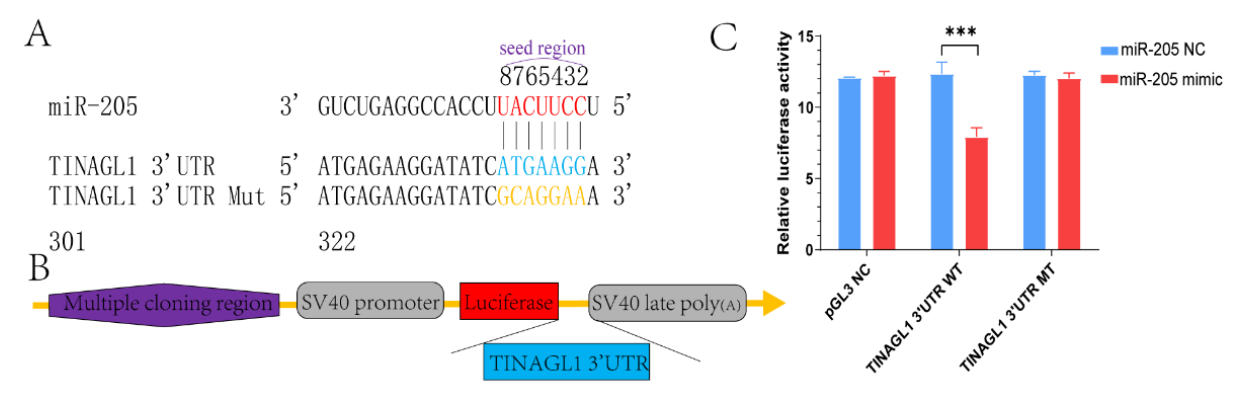
Figure 9. miR-205 targets the 3 (cid:48) -untranslated regions (3 (cid:48) UTR) of tubulointerstitial nephritis antigen-like 1 ( TINAGL1 ). ( A ) miR-205 seed sequence and TINAGL1 (cid:48) s 3 (cid:48) UTR predicted complementary pairing sites. ( B ) TINAGL1 3 (cid:48) UTR wide type (WT) was constructed downstream of the firefly luciferase reporter gene in the pGL3 promoter vector. ( C ) miR-205 mimic or miR-205 negative control (NC) was co-transfected into 293T cells with the PGL3 negative control (NC), TINAGL1 3 (cid:48) UTR WT plasmid, and TINAGL1 3 (cid:48) UTR mutant (MT) plasmid. In the groups that co-transfected miR-205 mimic and TINAGL1 3 (cid:48) UTR wide type, the firefly/Renilla luciferase activity was significantly decreased compared with the control group. Demonstrating that miR-205 may target TINAGL1 to affect luciferase activity. Data are presented as mean ± the standard error of the mean (SEM), *** represents p -value < 0.001.